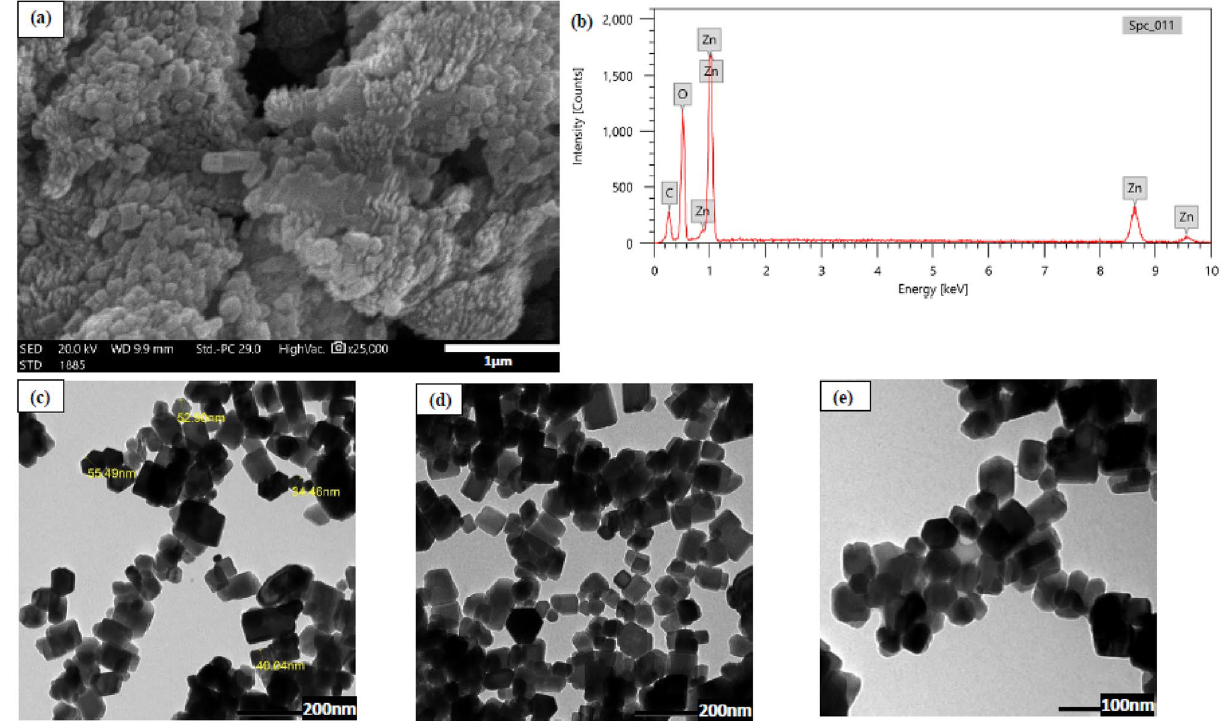
Figure 3. ( a ) SEM; ( b ) EDX; ( c – e ) TEM images of the phytosynthesized ZnO NPs. Plant species Shape Size (nm) References Artocarpus gomezianus Wall. ex Trécul Spherical 10–30 60 Berberis aristata DC Needle 20–40 Artocarpus heterophyllus Lam Spherical 12–24 Prosopis farcta (Banks & Sol.) J.F.